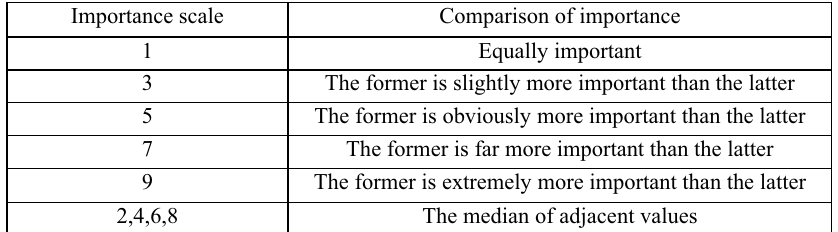
Fig. 2. Membership diagram of the input. Fig. 3. Membership diagram of the output. Table 1. 1 ~ 9 Scaling method.